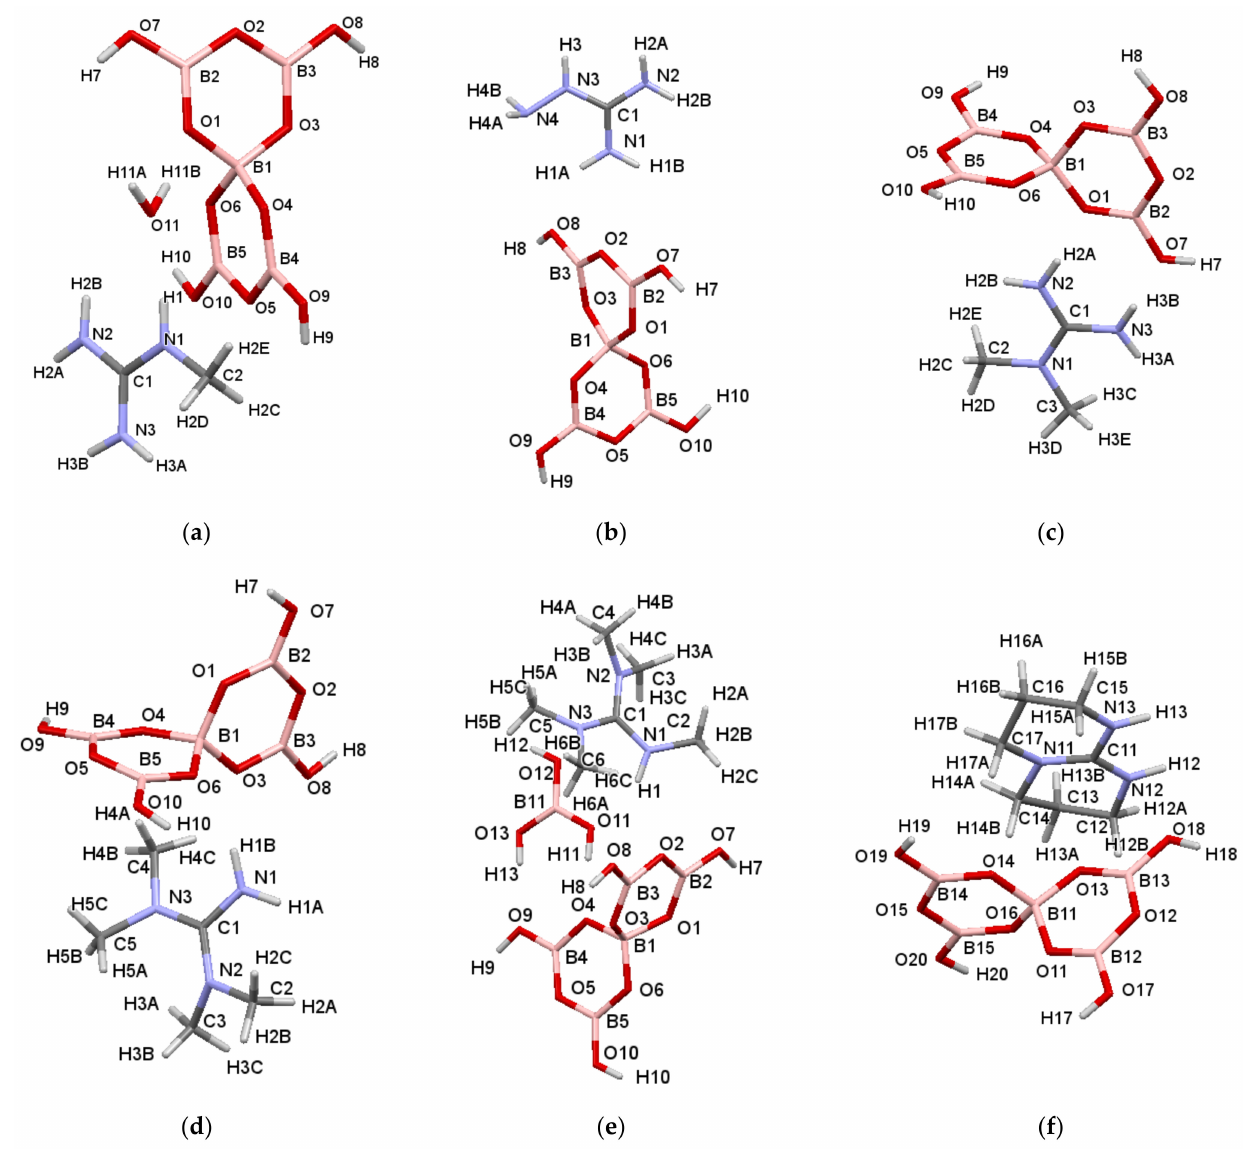
Figure 2. Drawings of the crystals structures of ( a ) [C(NH 2 ) 2 (NHMe)][B 5 O 6 (OH) 4 ] · H 2 O ( 1 ), ( b ) [C(NH 2 ) 2 (NH{NH 2 })][B 5 O 6 (OH) 4 ] ( 2 ), ( c ) [C(NH 2 ) 2 (NMe 2 )][B 5 O 6 (OH) 4 ] ( 3 ), ( d ) [C(NH 2 ) (NMe 2 ) 2 ][B 5 O 6 (OH) 4 ] ( 4 ), ( e ) [C(NHMe)(NMe 2 ) 2 ][B 5 O 6 (OH) 4 ] · B(OH) 3 ( 5 ), and ( f ) [TBDH][B 5 O 6 (OH) 4 ] ( 6 ) (TBD = 1,5,7-triazabicyclo[4.4.0]dec-5-ene) showing atomic numbering. Compound 6 is modulated and just one component of the disordered anion and cation is shown in ( f